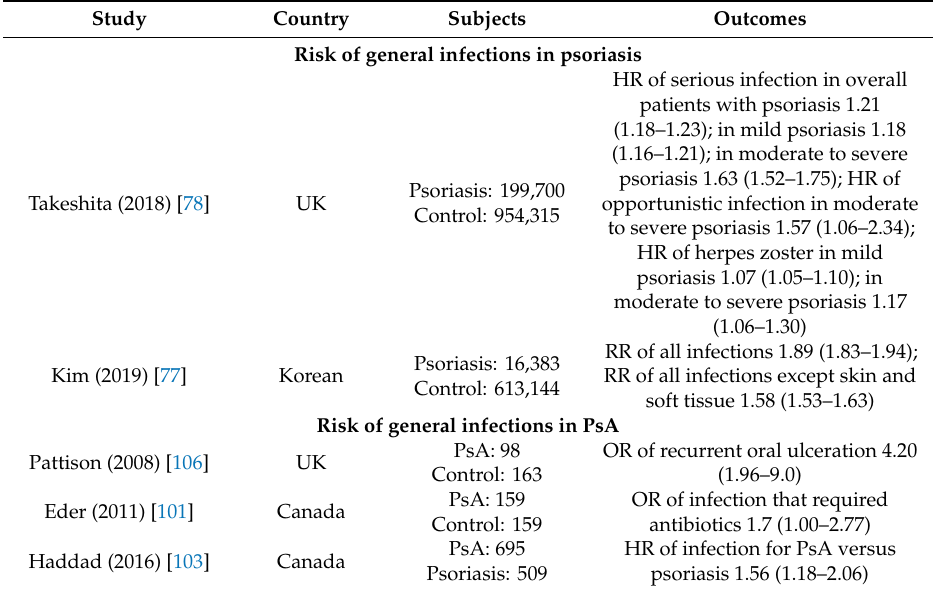
Table 4. Summary of the epidemiological studies investigating the risk of infection in patients with psoriasis and psoriatic